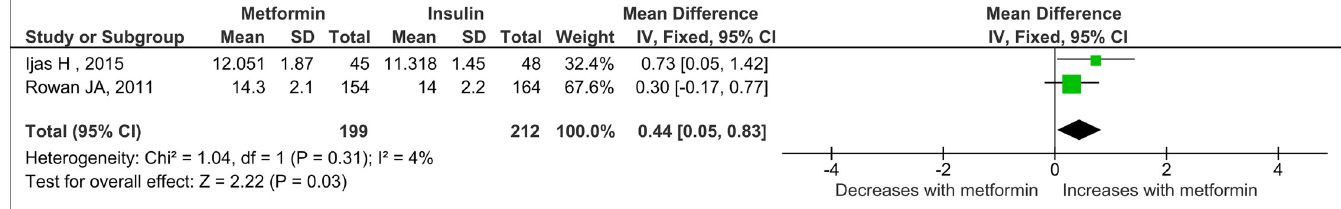
PLOS Medicine| https://doi.org/10.1371/journal.pmed.1002848 August 6,